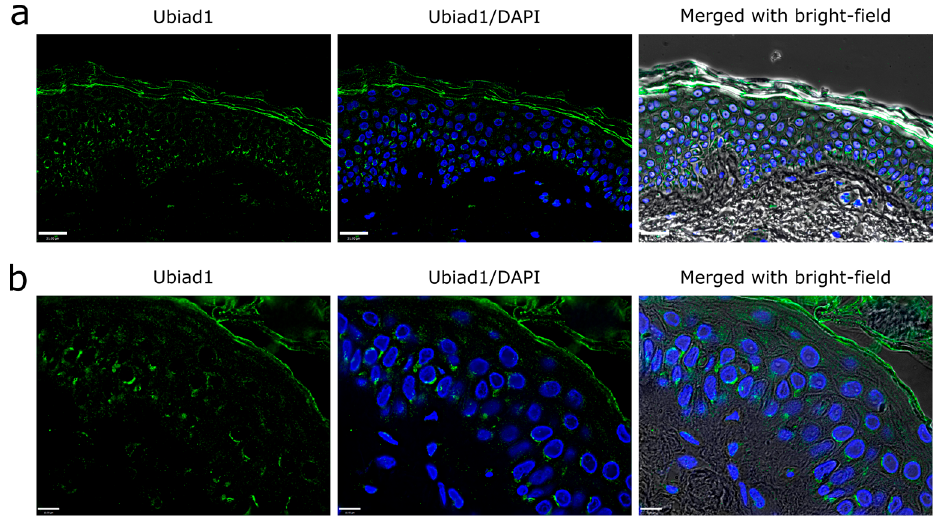
Figure 1. Expression of Ubiad1 in normal skin. ( a ) Immunodetection of Ubiad1 (green) and DNA stained with 4 ′ ,6-diamidino-2-phenylindole (DAPI) (blue), Ubiad1 is positive in the epidermal spinous and basal layers (×20 objective lens, scale bar = 31 µm); ( b ) Immunodetection of Ubiad1 (green) and DNA stained with DAPI (blue), Ubiad1 appears to a tight perinuclear localization, polarly confined (organelle-like) (×63 objective lens, scale bar = 10 µm).